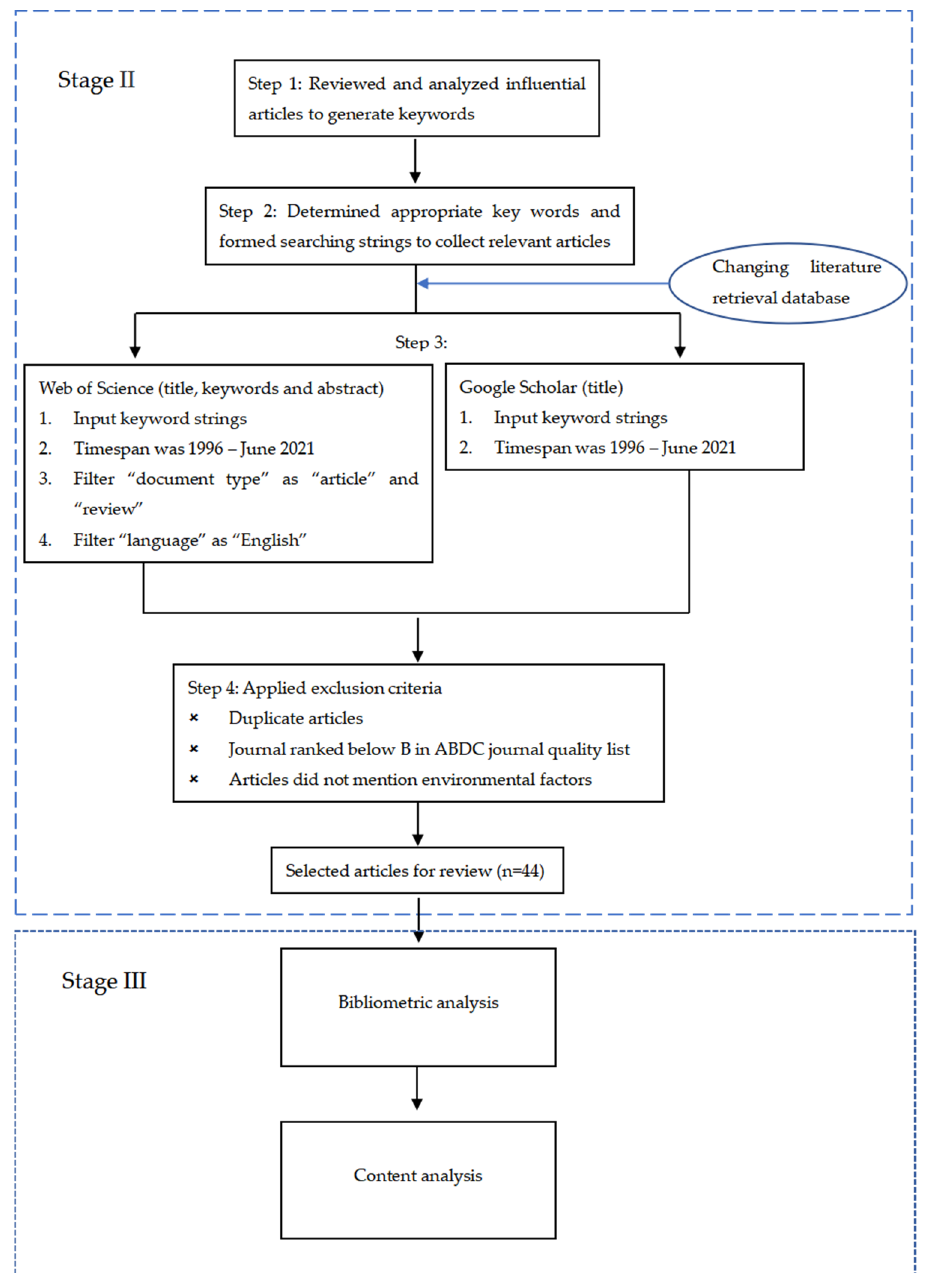
Figure 1. Stages II and III of the SLR method are conducted in this paper.